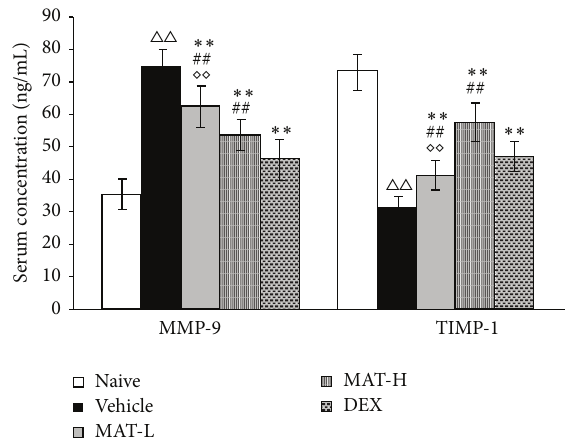
Figure 5: Serum concentration of MMP-9 and TIMP-1. At day 17 p.i., sera were harvested from treated and nontreated EAE rats, with sera from naive rats serving as control. MMP-9 and TIMP- 1 production was determined by ELISA. Results are expressed as mean ± SD ( 𝑛 = 8 each group). △△ 𝑃 < 0.01 , compared to naive group; ∗∗ 𝑃 < 0.01 , compared to the vehicle group; ## 𝑃 < 0.01 , compared to the DEX group; ◊◊ 𝑃 < 0.01 , comparison between MAT-L and MAT-H